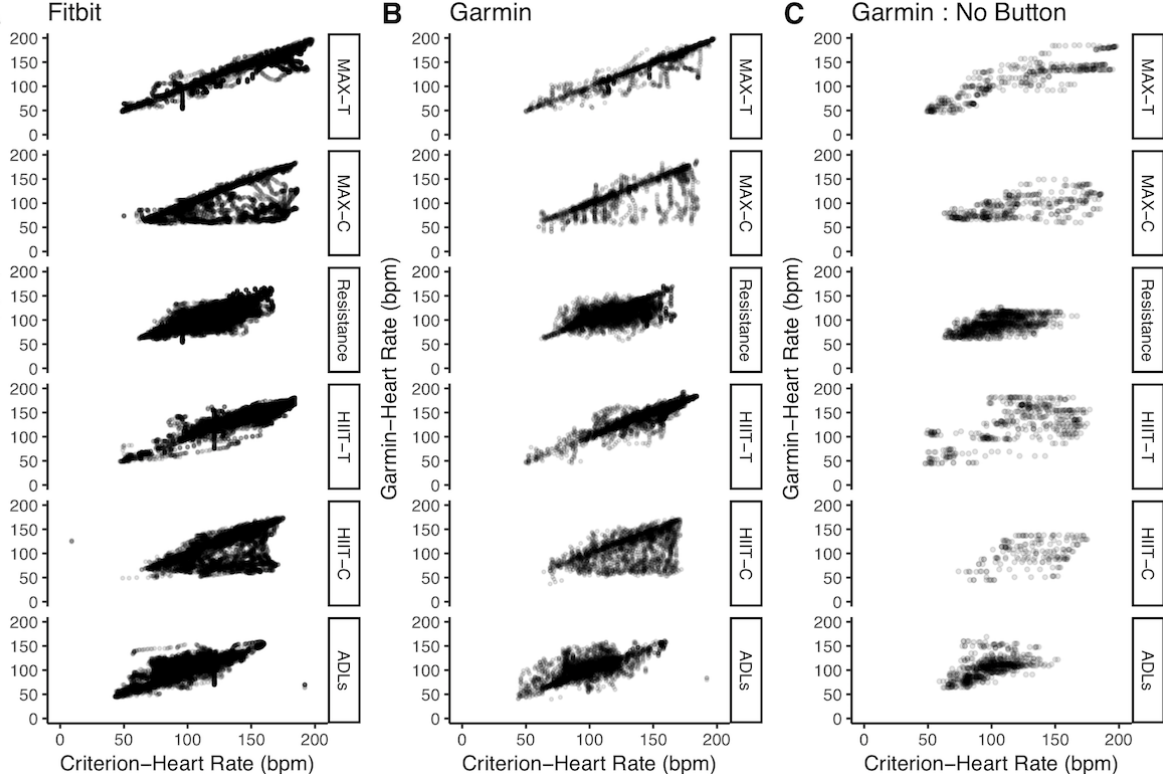
Figure 3. Scatter plots showing HR measurements from Fitbit and Garmin versus the reference standard Polar across all activities. Panel A shows the correlation plot comparing the Fitbit versus the Polar. Panel B shows the correlation plot comparing the Garmin (with activity mode indicated) versus the Polar. Panel C shows the correlation plot for a subset of the subjects comparing the Garmin (with activity mode not indicated) versus the Polar. ADLs: activities of daily living, HIIT-C: high-intensity interval training-Cycle ergometer, HIIT-T: high-intensity interval training-Treadmill, MAX-C: MAX-Cycle ergometer, MAX-T: